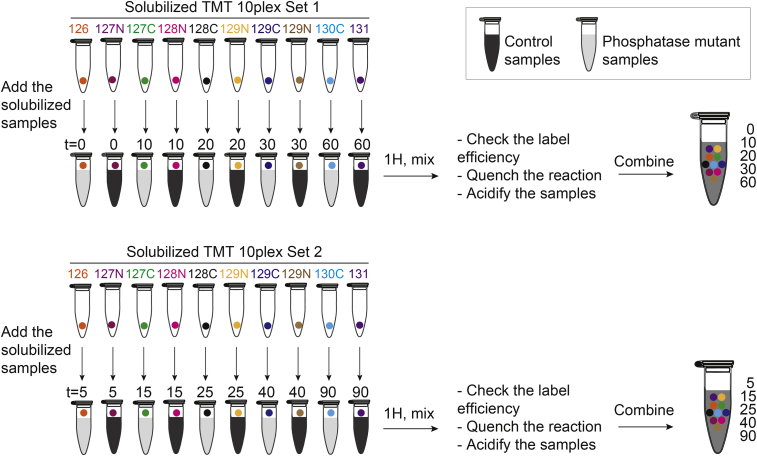
Labeling with TMT10plex Isobaric Mass Tag Reagents Sets